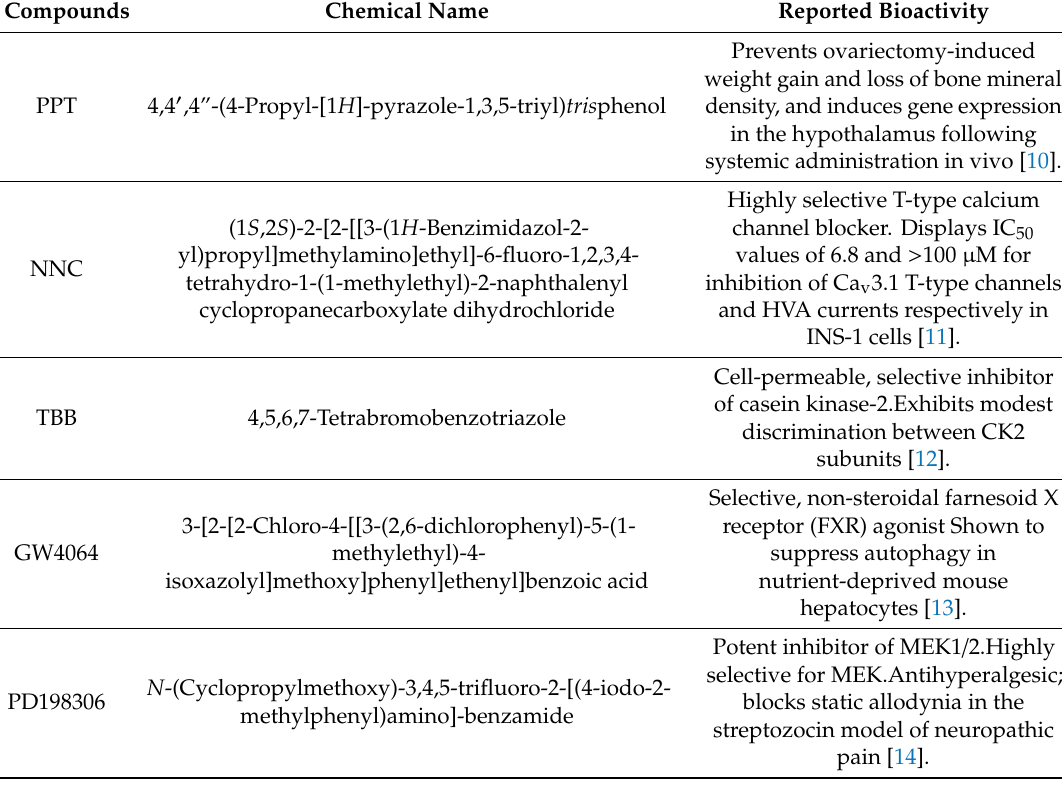
Table 1. List of compound names and reported bioactivities.